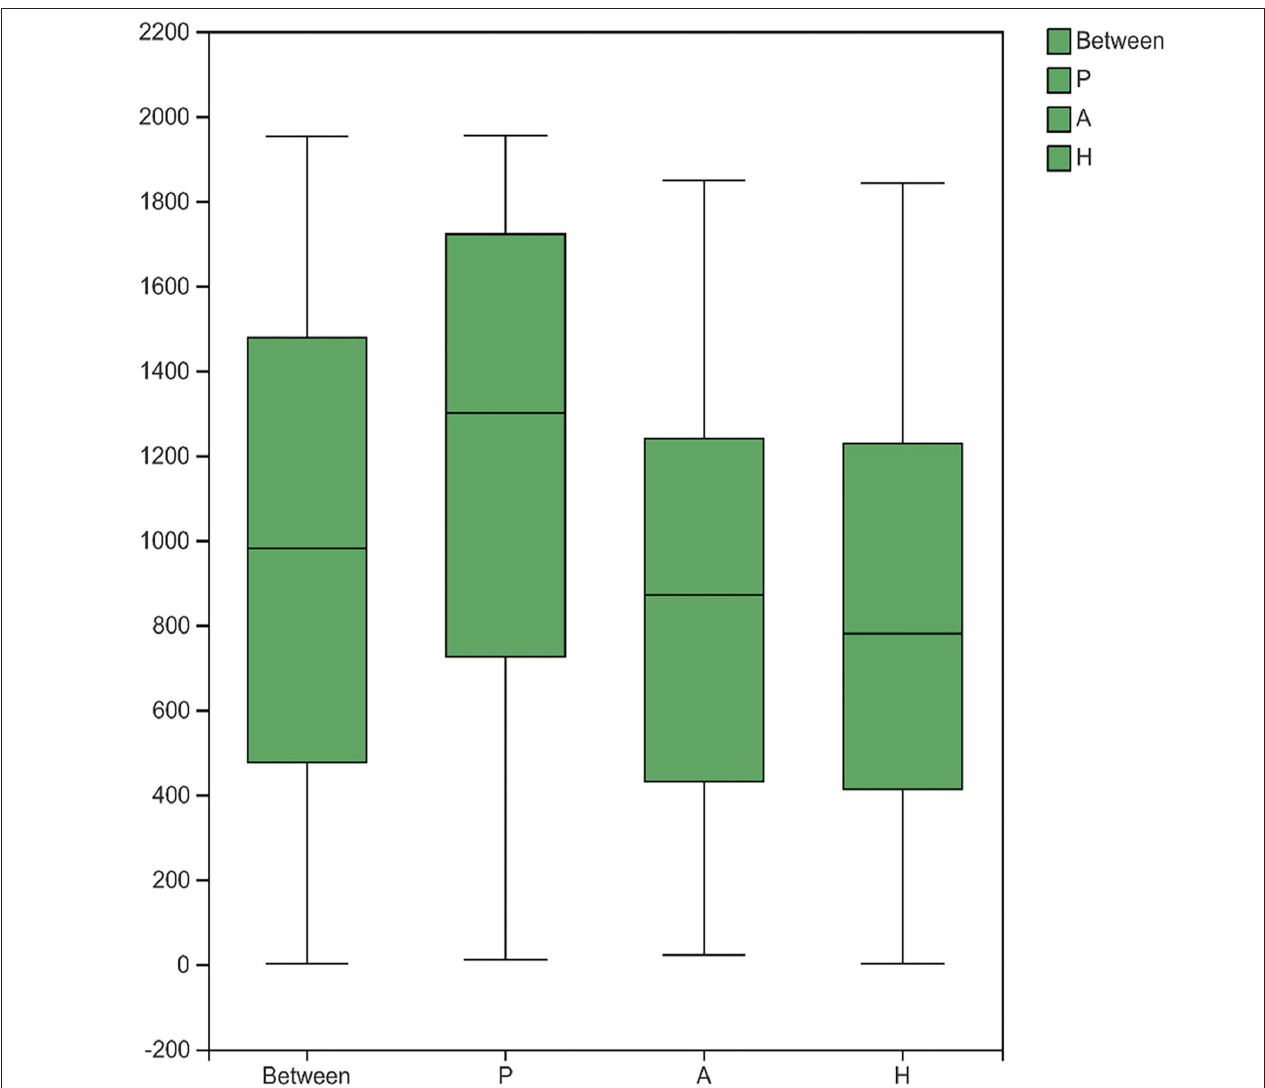
FIGURE 10 | Analysis of similarities (ANOSIM/Adonis) between the fungi. The ordinate represented the rank of distance calculated on the operational taxonomic unit (OTU) level of each group.